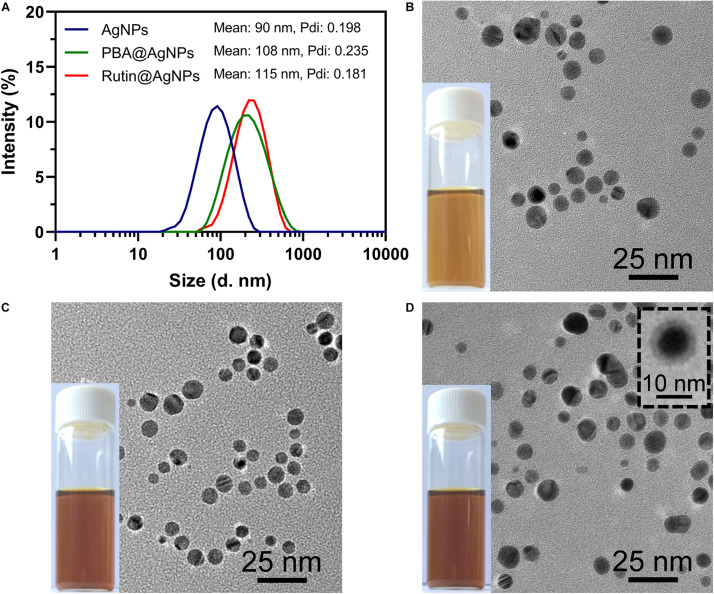
(A) Size distributions of three types of NPs; TEM images and photographs of (B) AgNPs, (C) PBA@AgNPs, and (D) Rutin@AgNPs. The insert image showed Rutin@AgNPs were negatively stained with phosphotungstic acid.